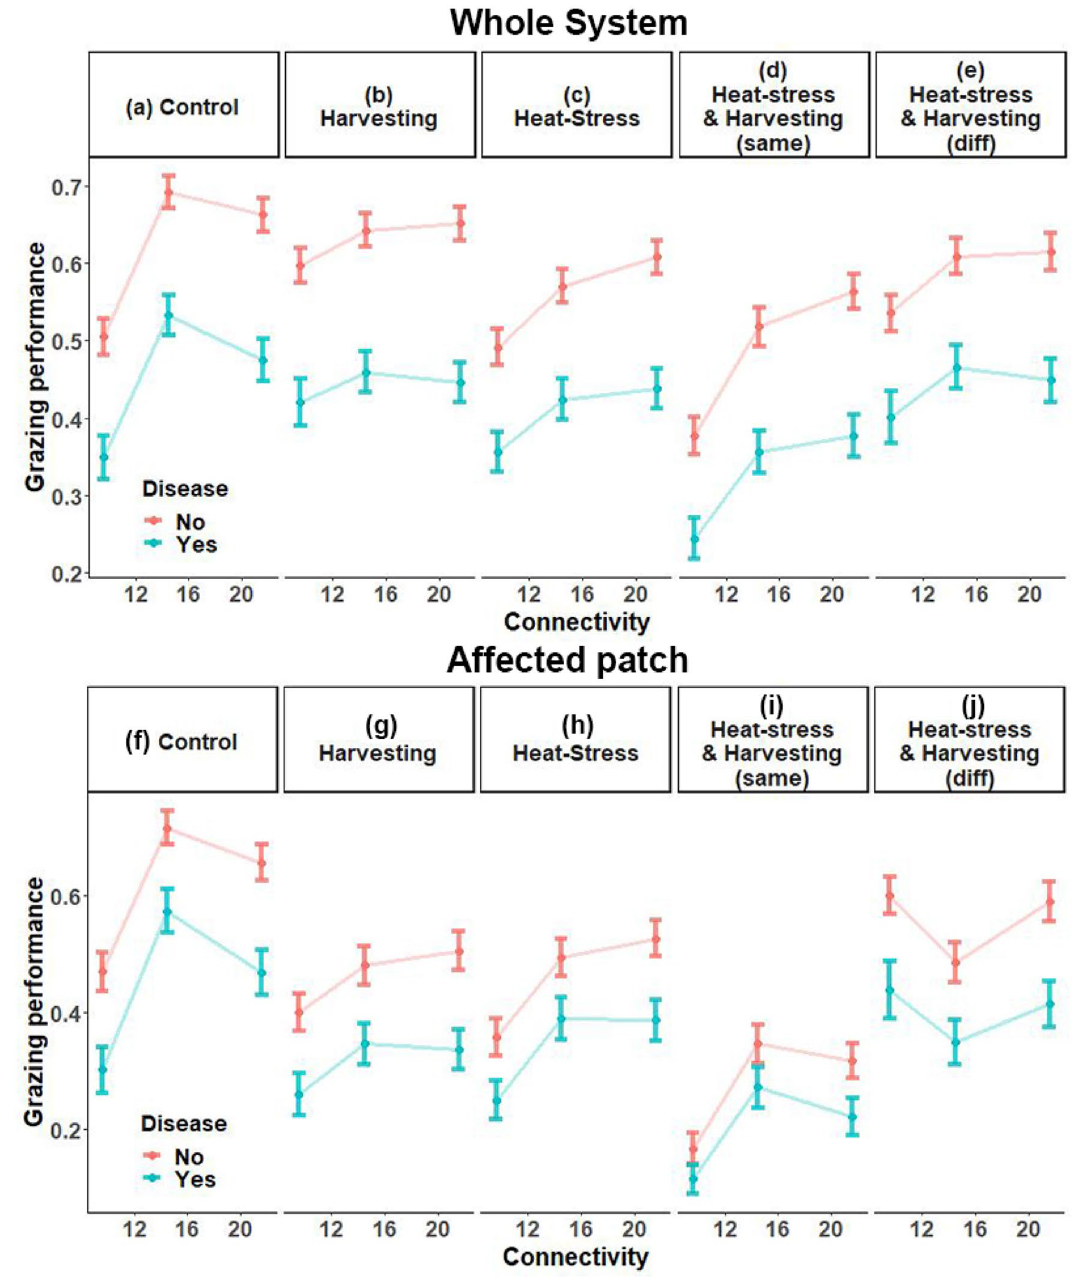
Figure 2. Grazing performance in response to ten experimental disturbance treatments at three connectivity levels. Grazing performance is algal consumption as a proportion of total algae available (mean ± SE). In d: both stressors were applied to the same patch (same). In e: stressors were applied to different patches